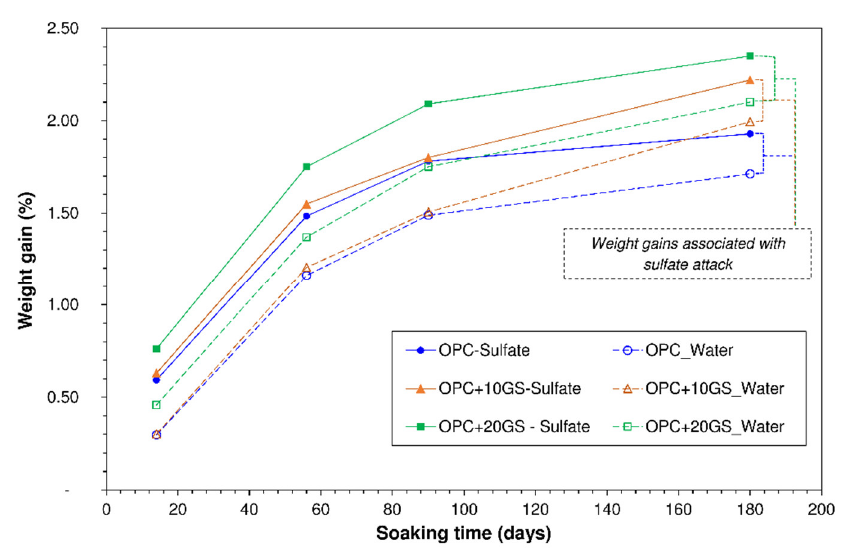
Figure 3. Cement paste weight gain vs. soaking time.